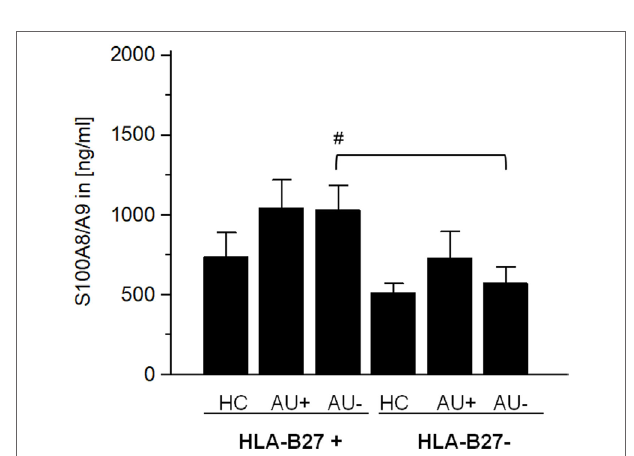
FigUre 4 | Serum level of S100A8/A9 (in ng/ml) as mean ± SEM of HLA-B27-positive/-negative healthy controls (HCs), and patients with active (AU + ) and inactive (AU − ) anterior uveitis analyzed by ELISA (* p < 0.05; Kruskal–Wallis test; # p < 0.05; Mann–Whitney U -test).